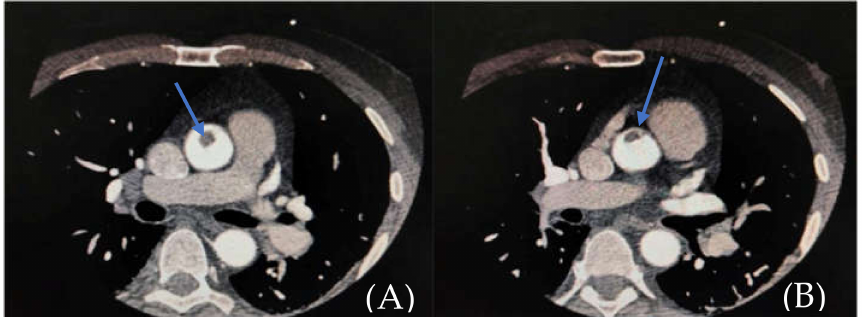
Figure 3. ( A , B ). CTA showing endoluminal aortic thrombus (filling defect in the ascending aorta— blue arrow).